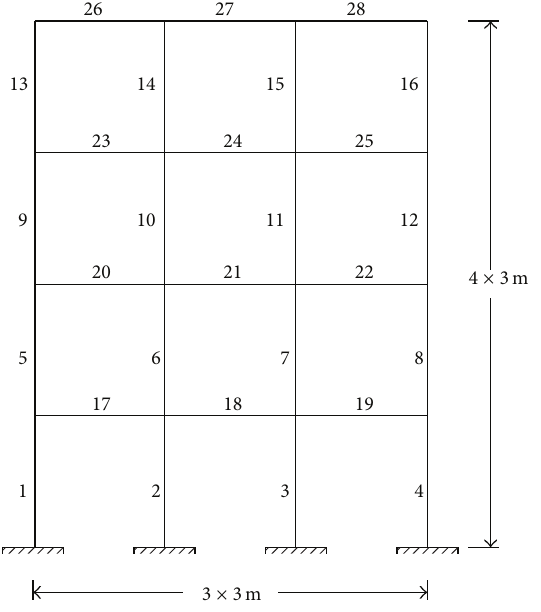
Figure 7: 3-Bay, 4-storey frame model.